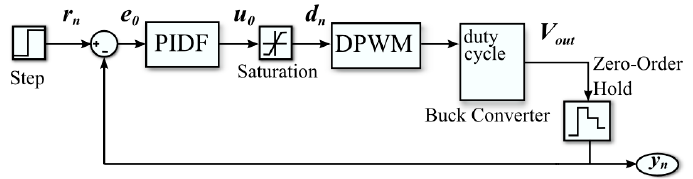
Figure 6. MATLAB-Simulink ® model of the buck converter and control system.